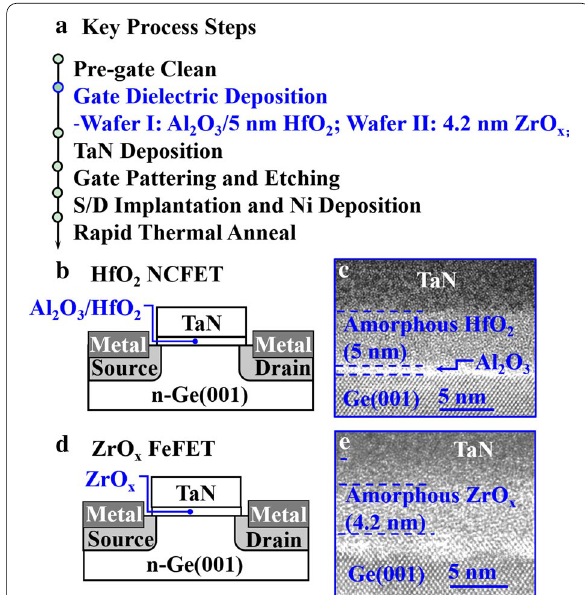
Fig. 1 a Key process steps for the fabrication of the Al 2 O 3 /5 nm HfO 2 NCFETs and 4.2 nm ZrO x NCFETs. b Schematics and c HRTEM images of the fabricated ZrO x NCFETs. d Schematics and e HRTEM images of the fabricated Al 2 O 3 /HfO 2 NCFETs